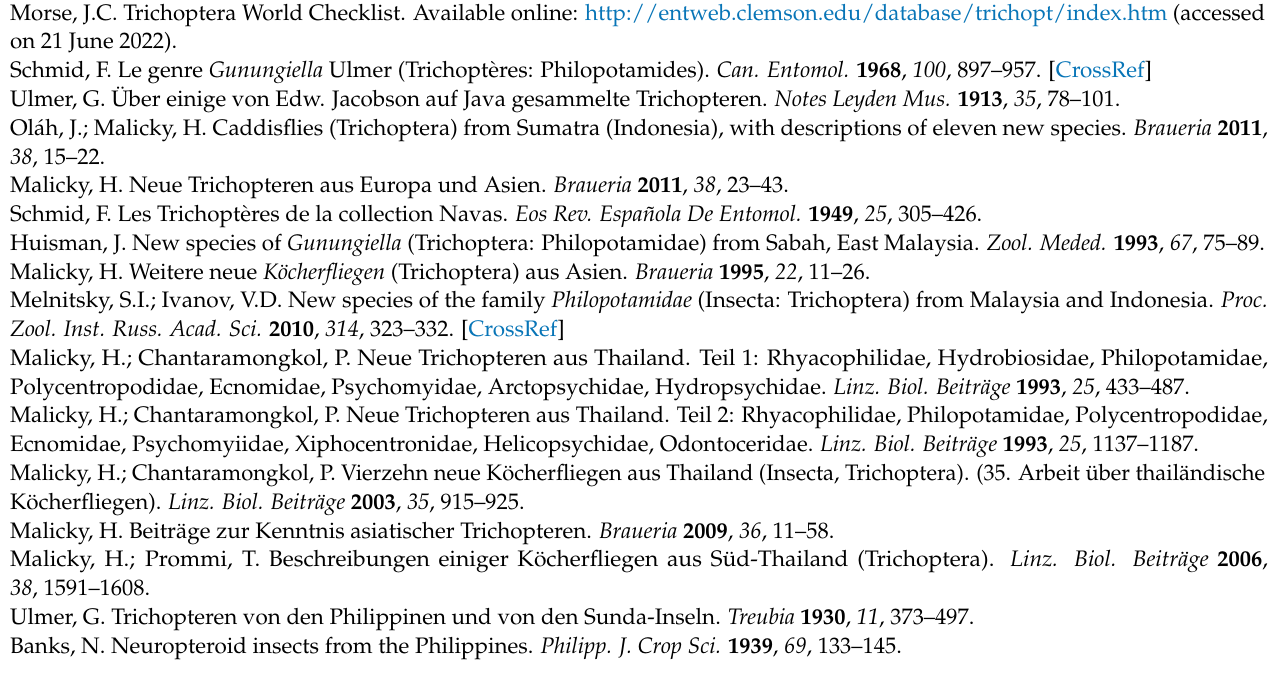
Table S2: Nucleotide composition of mitogenomes of six philopotamid species. Table S3: PCR primers used to sequence mt COI genes of Trichoptera in this study. Table S4: The best model for each partition of the three Matrixs. Figure S1: Start codons of PCGs among Trichoptera mitogenomes. Figure S2: Heterogeneity of sequence composition for different datasets. The pairwise Aliscore values are represented by colored. The scores range from − 1 showing full random similarity (dark blue), to +1 showing non-random similarity (shiny red): (a) PCGFAA; (b) PCG12R; (c) PCG12; (d)